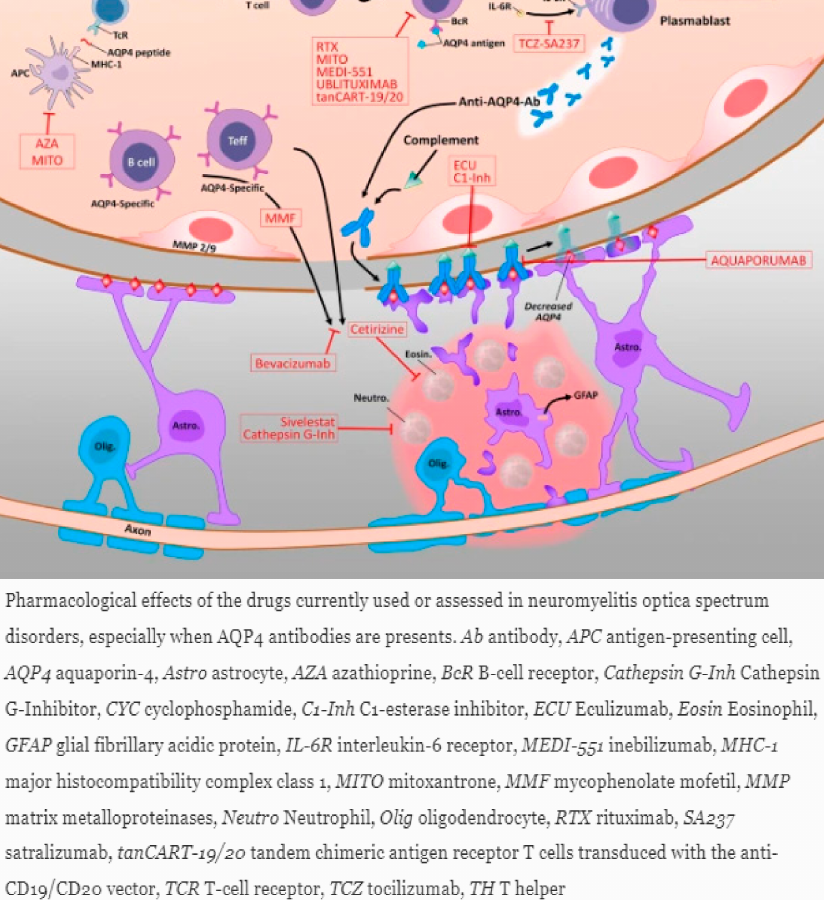
Figure 5. Pharmacological Effects of the drugs used in NMOSD [115].